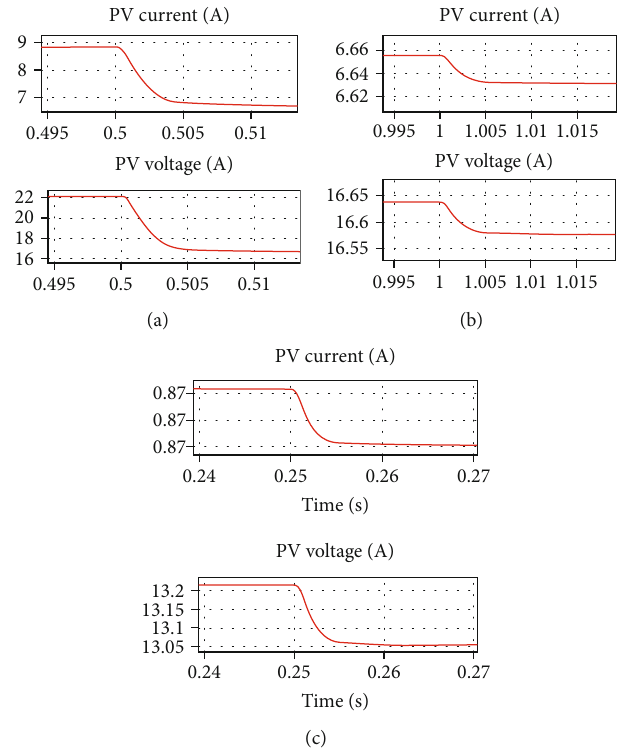
Figure 14: Transient response for changes in (a) irradiance, (b) temperature, and (c) ratio of partial shading.